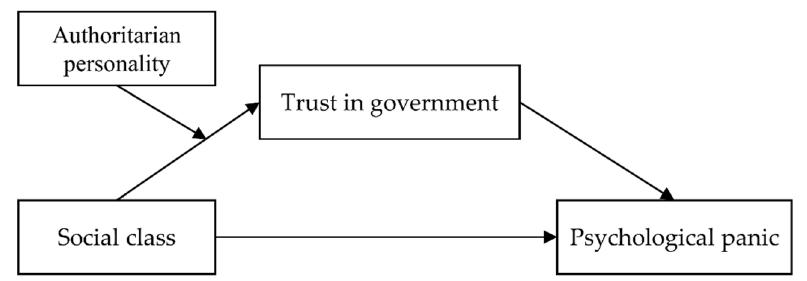
Figure 1. Hypothesized model.